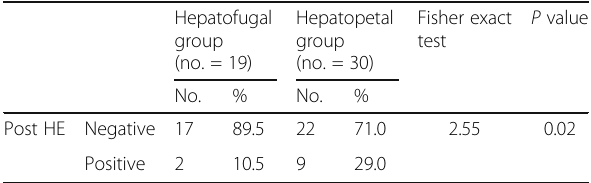
Table 2 Comparison between studied groups regarding indication of TIPS Indication Table 3 Comparison between the studied groups regarding